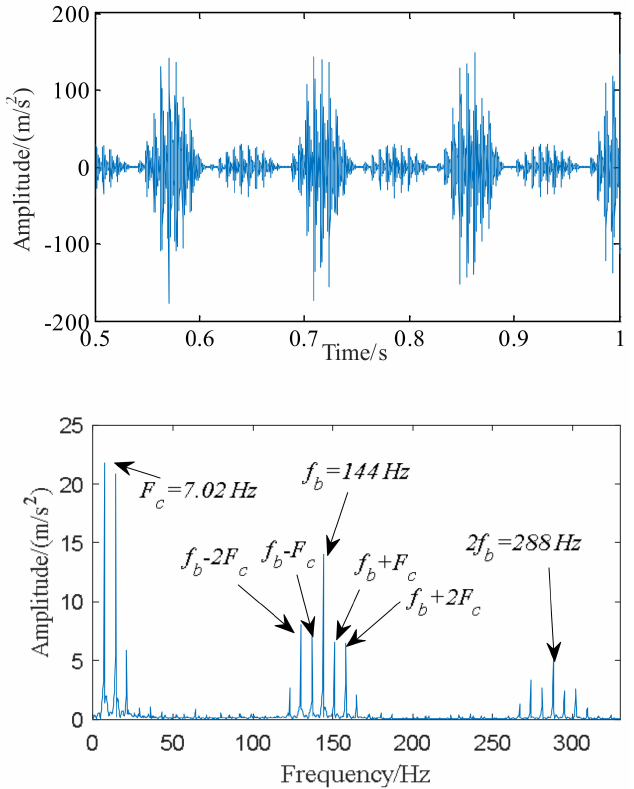
Figure 17. Time–domain signal and envelope spectrum of roller fault (numerical